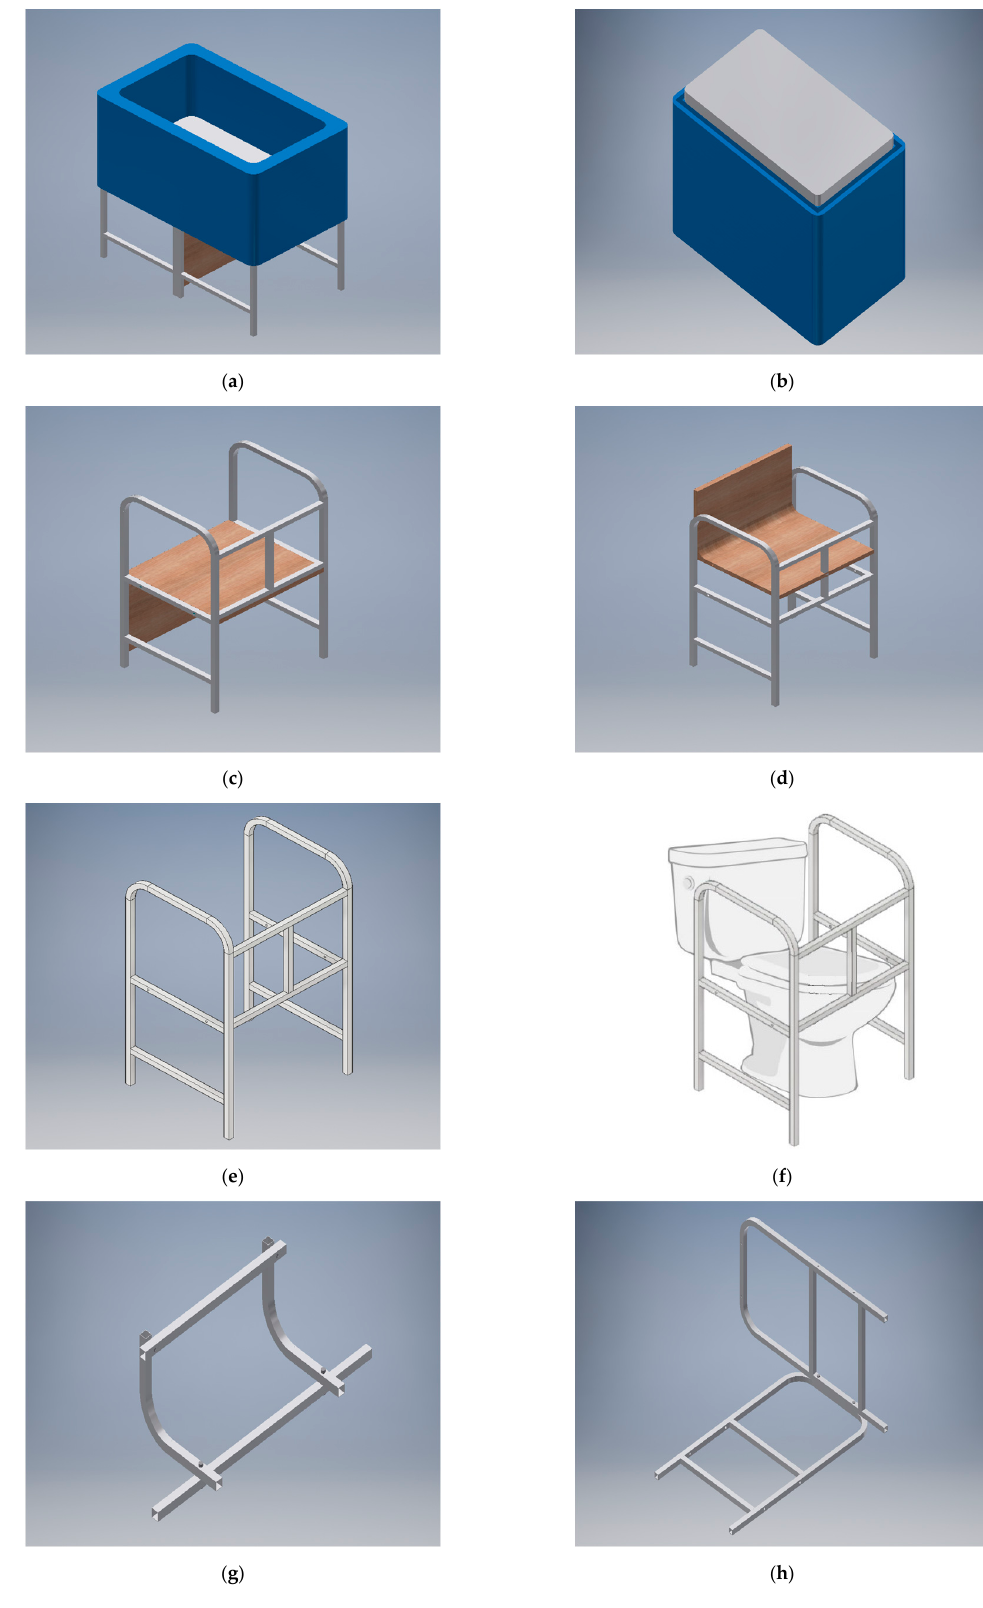
Figure 2. Designs for repurposed parts of concept 1. ( a ) Crib design. ( b ) Cushioned seat design. ( c ) Chair design. ( d ) Highchair design. ( e ) Walker design. ( f ) Toilet attachment design. ( g ) Pull-up bar design. ( h ) Safety rail